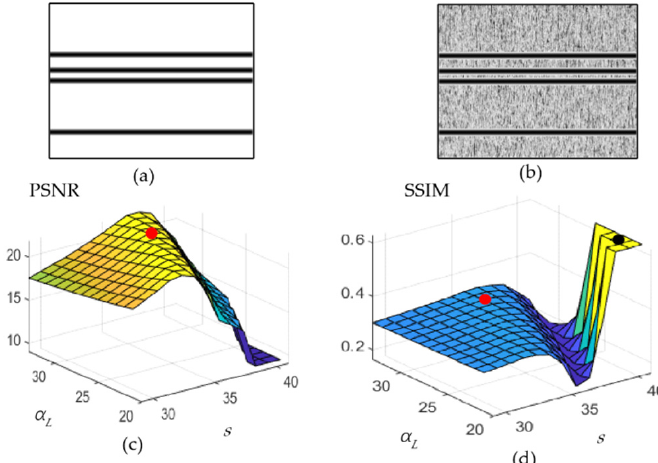
Figure 5. Illustration of parameter settings. ( a ) and ( b ) show the first synthetic clean SBP image and the polluted SBP image, respectively. ( c ) shows the peak signal-to-noise ratio (PSNR) surface and the red point has the highest value, ( d ) shows the structural similarity index (SSIM) surface obtained similarly to the PSNR surface and the red point has the highest value.